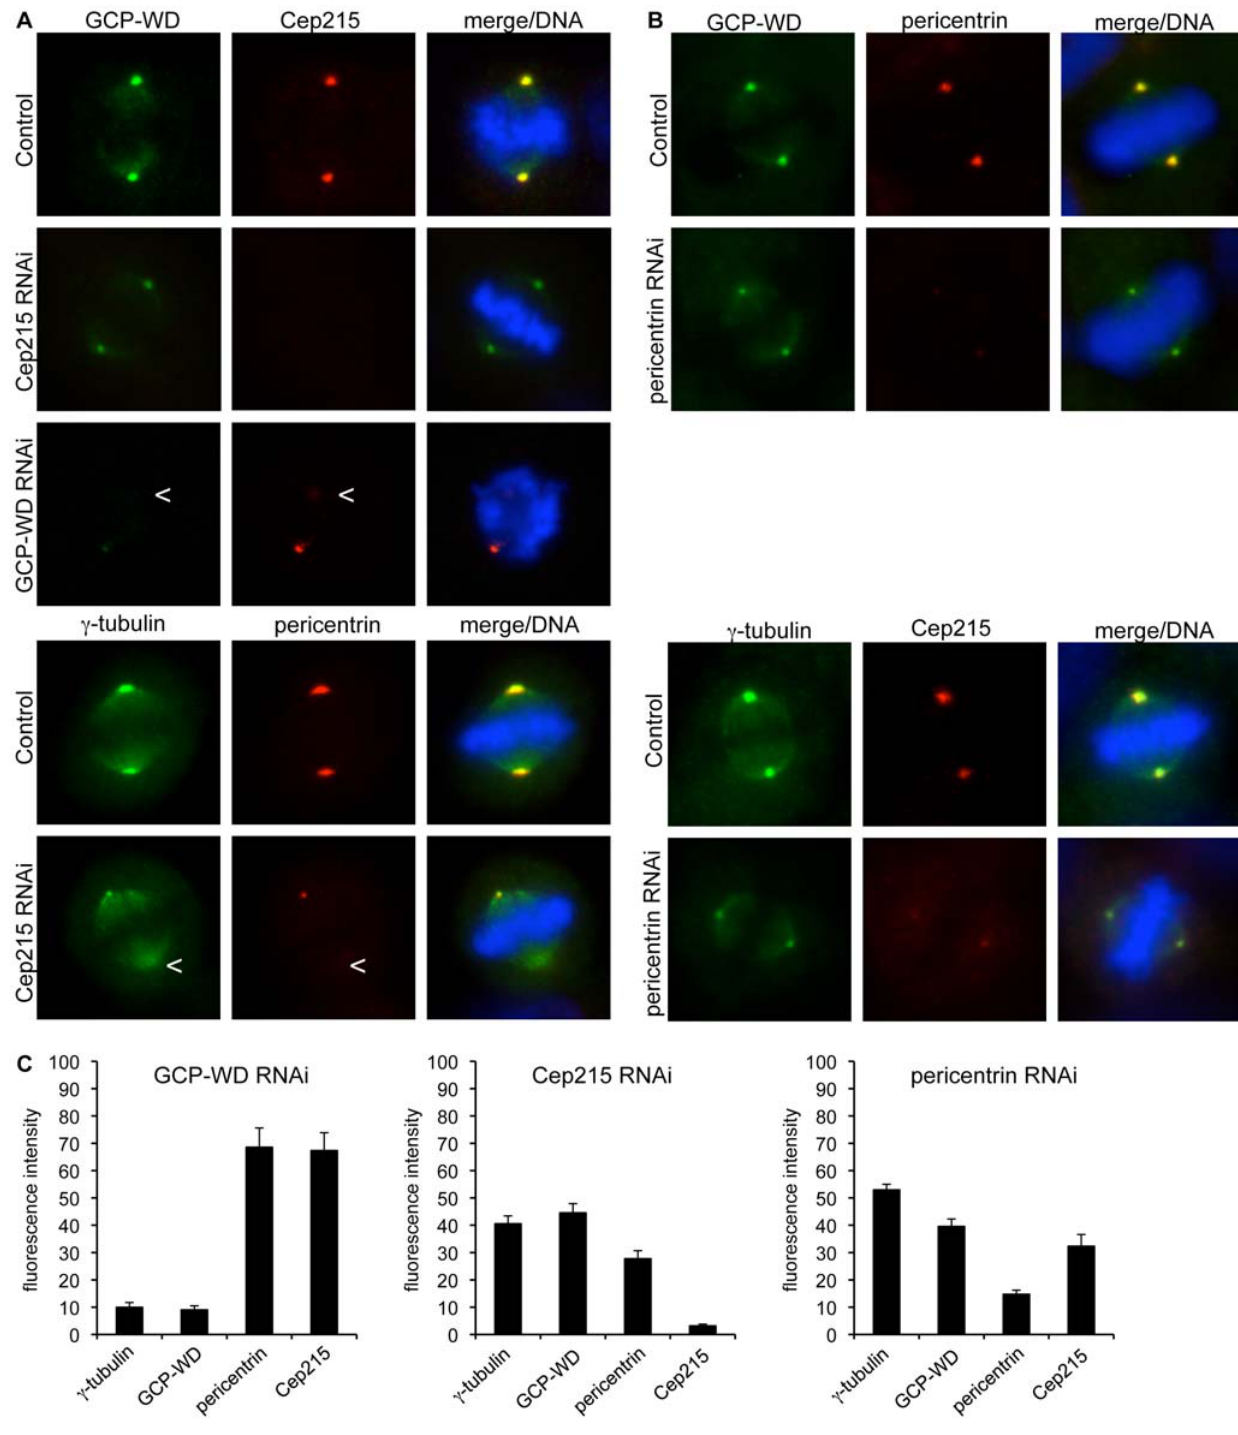
Figure 6. Cep215 and pericentrin depend on each other for localizing to mitotic centrosomes and function upstream of GCP-WD in c -tubulin recruitment. (A) HeLa cells transfected with plasmids expressing shRNA targeting Cep215 or GCP-WD, were fixed and stained for GCP- WD and Cep215 or c -tubulin and pericentrin. DAPI was used to label DNA. As a control cells were transfected with empty vector. In some panels one of the two centrosomes is out of focus and only one centrosome can be seen. The arrowhead marks the position of the out-of-focus centrosome, which in both cases was labelled with similar intensity as the one shown. (B) HeLa cells transfected with siRNA targeting pericentrin were processed for immunofluorescence with antibodies against c -tubulin and Cep215 or GCP-WD and pericentrin. DAPI was used to visualize DNA. Unspecific RNA was transfected as a control. (C) After depletion of the indicated proteins by RNAi cells were fixed and stained with antibodies against c -tubulin, GCP- WD, pericentrin and Cep215. Fluorescence intensities at mitotic centrosomes were quantified (n $ 10 cells/20 centrosomes per condition). Intensities were plotted as a percentage of the intensities measured in control cells. Error bars: SEM, 95% CI.